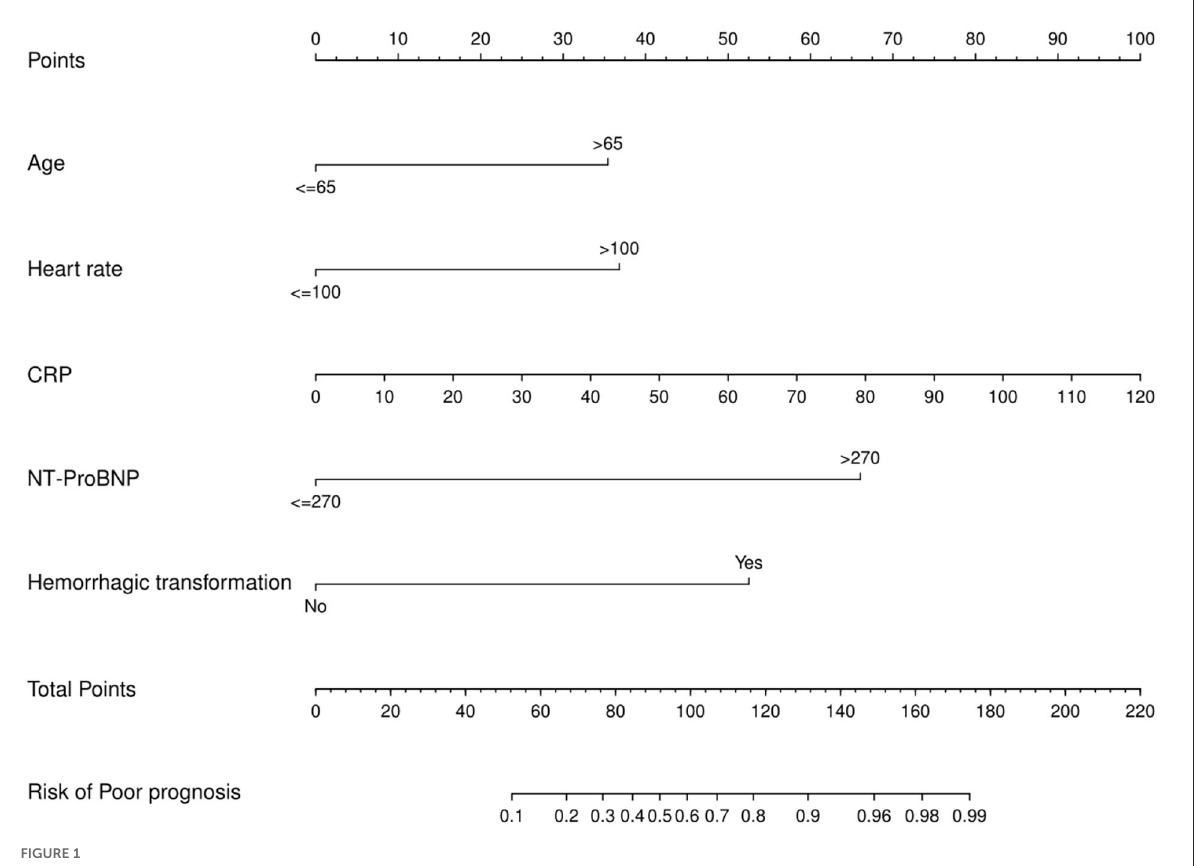
FIGURE1 Nomogram for predicting the probability of AF in